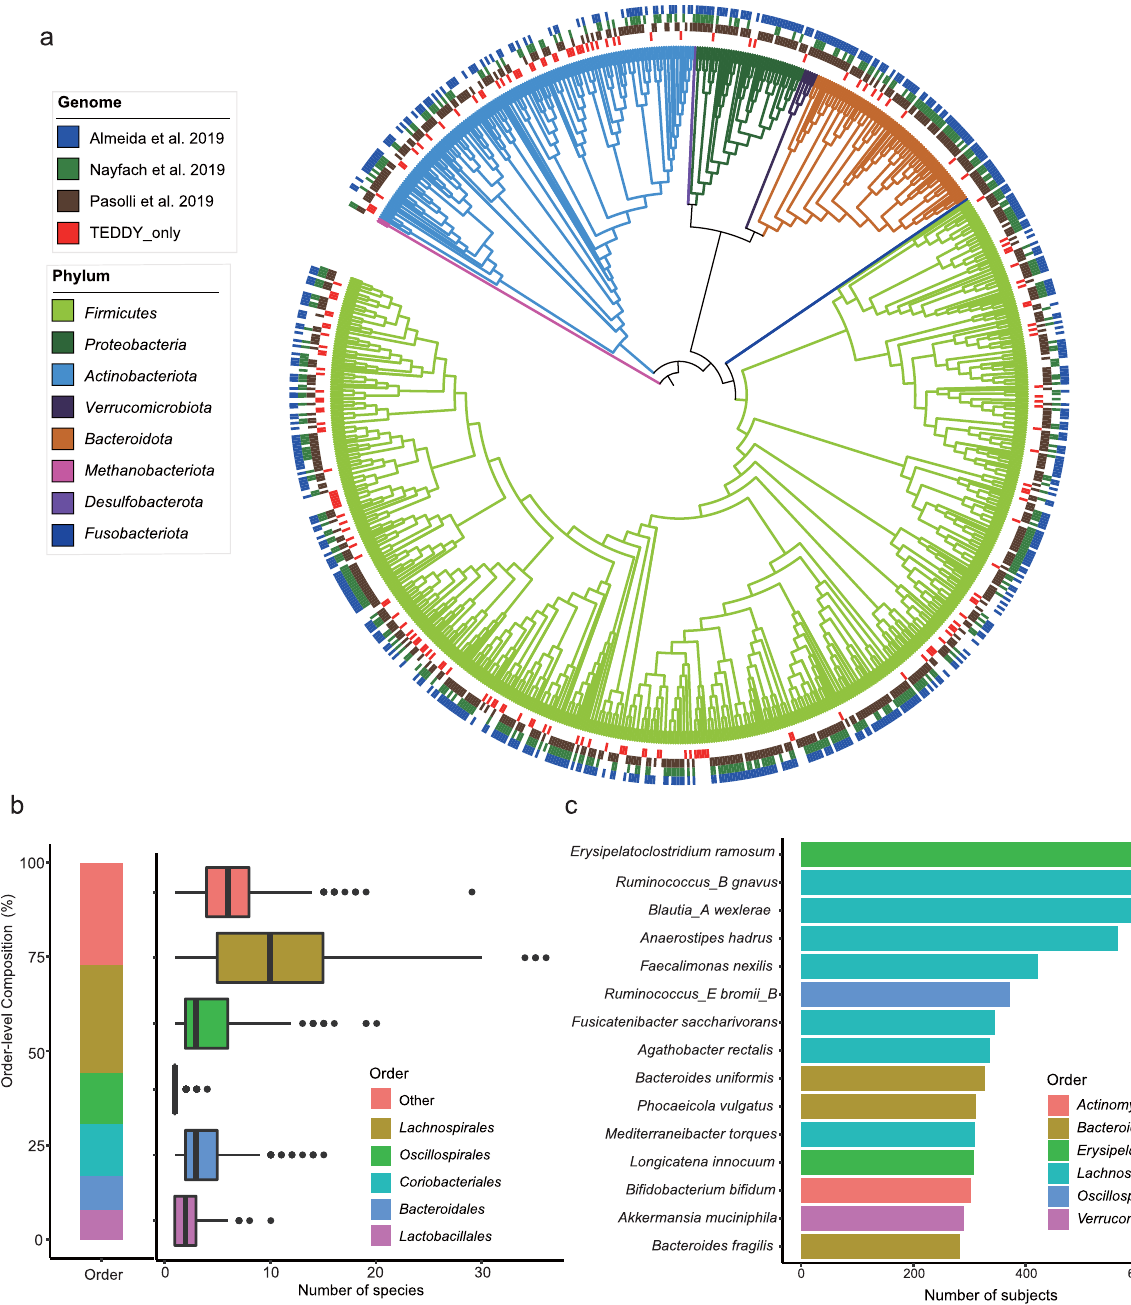
Fig. 1 Phylogeny and taxonomy distribution of high-quality MAGs from TEDDY. a Taxonomy tree of the 883 species represented by TEDDY MAGs. Branches are colored at the phylum level. The four rings mark the 567 species matched to Almeida, et al. 21 in blue, the 458 species matched to Nayfach, et al. 18 in green, the 626 species matched to Pasolli, et al. 22 in brown, and the 176 species only identi fi ed from TEDDY in red. b Order-level composition of the 883 TEDDY species (left) and the number of species per subject in each order (right). Only the fi ve most common orders, Lachnospirales ( n = 823 subjects), Oscillospirales ( n = 648), Coriobacteriales ( n = 321), Bacteroidales ( n = 698), and Lactobacillales ( n = 615), are shown individually, while the remaining orders are grouped as ‘ other ’ ( n = 3752). Most subjects had less than 10 species from each of the orders except Lachnospirales . Boxplots show the median (center), the fi rst and third quartile (bounds of box), and 1.5X interquartile ranges (whiskers). Points beyond the ends of whiskers are outliers. c Species identi fi ed in the largest numbers of subjects in TEDDY, colored by orders. Source data are provided as a Source Data fi